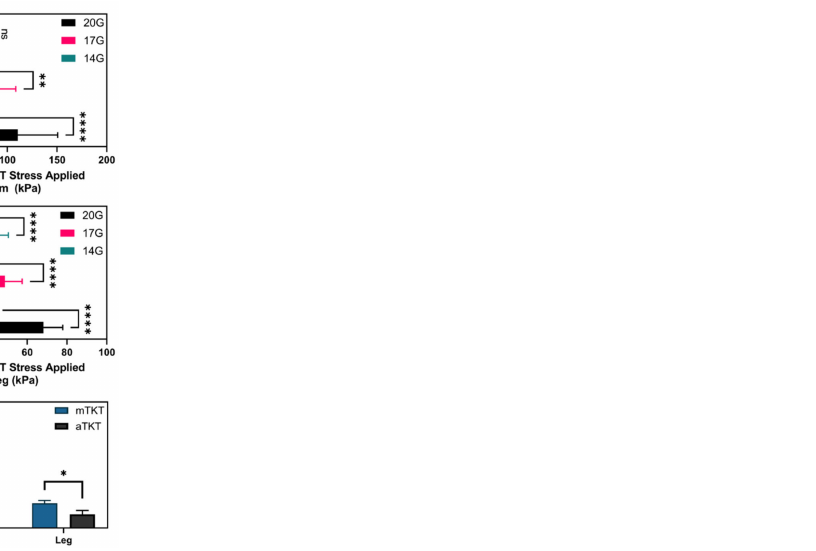
Figure 5. Comparison of TKT application stress for aTKT and mTKT. Maximum application stress (kPa), as determined by force sensor placed under the TKT, for both the aTKT and mTKT using the synthetic ( A ) arm or ( B ) leg test setup. Average results are shown for three hemorrhage rates ( n = 12). Significant differences between application stresses were determined by two-way ANOVA, post-hoc Sidak’s test. ( C ) Coefficient of variations for the arm and leg TKT stress results for the aTKT and mTKT. Coefficient of variation was calculated as the standard deviation relative to the average for each data set ( n = 3). Significant differences between application stresses were determined by unpaired t -test (*, p < 0.05; **, p < 0.01; ****, p < 0.0001; ns = not significant). Error bars denote standard deviation.